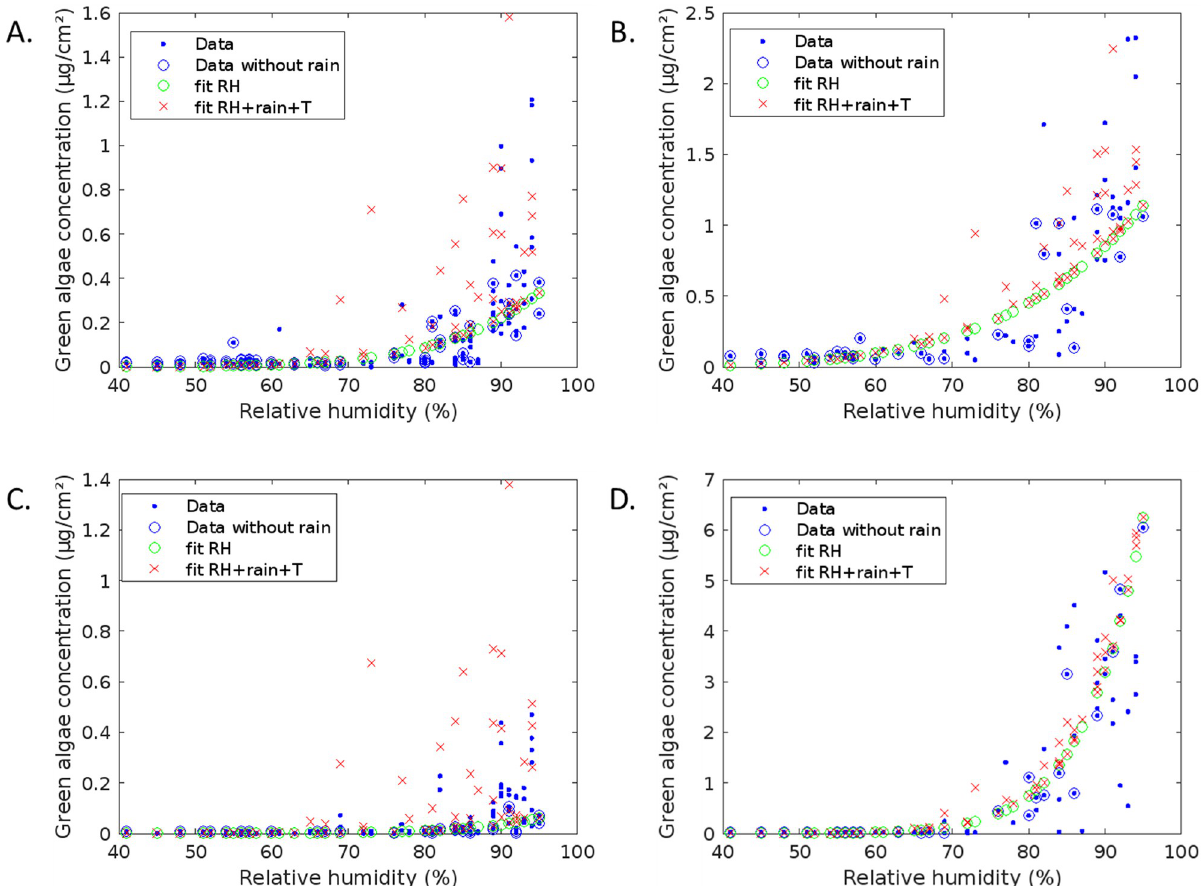
Fig 6. Green algae concentration as a function of RH. Measured data (blue points = all, blue circles = only data for day without rain) and data calculated using DRF by considering only RH (Eq (1), Table 6, green circles) or RH, rain and T (Eq (3), red crosses) for each situation: A. VA1 and VA2 (Eq (3) becomes Eq (4)); B. VA3 (Eq (5); C. VNA4 and VNA5 (Eq (6); D. VNA6 (Eq (7)).